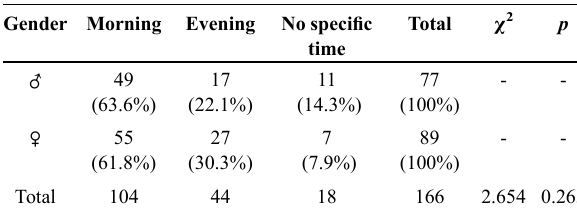
Table 2 - Absolute and relative distribution (%) of preferred training hours by gender.